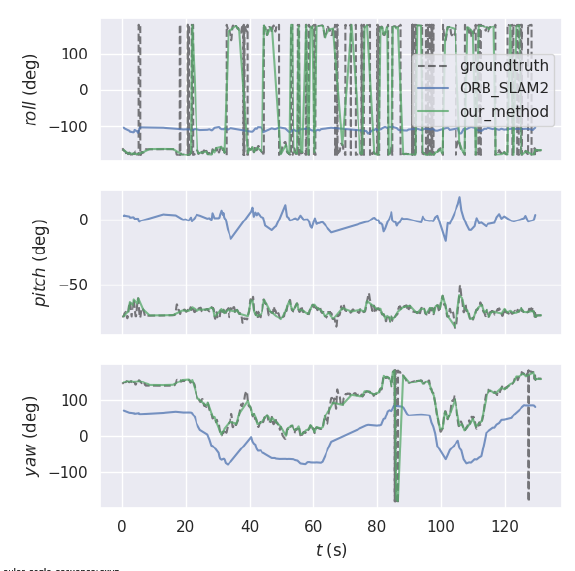
Figure 12. Euler angle of MH03 predicted by ORB_SLAM2 and our